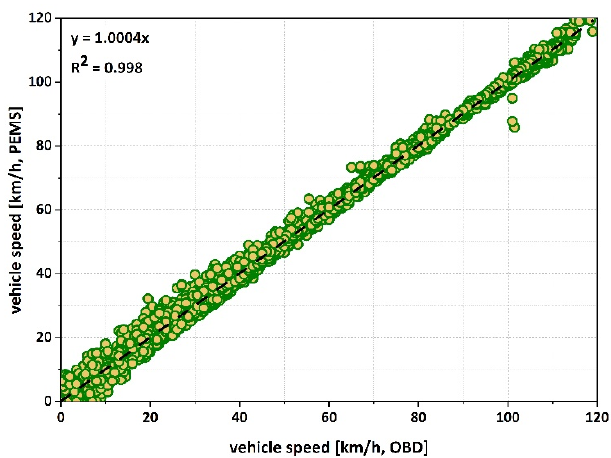
Figure 8. Correlation of vehicle speed measured by the PEMS and SEMS equipment.